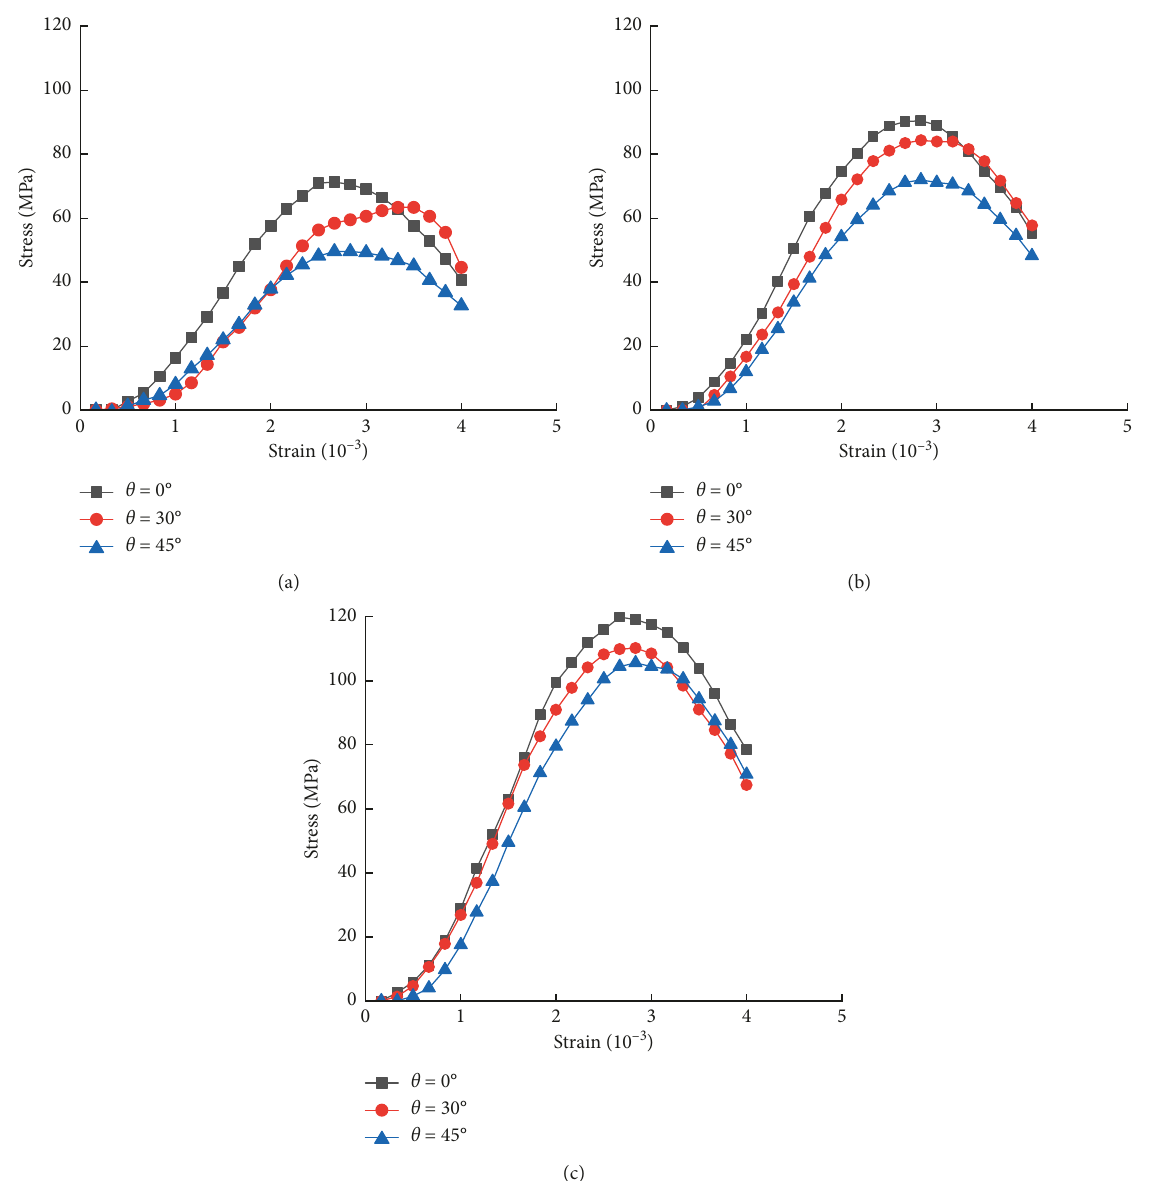
Figure 7: Stress-strain relation curves of different joints under three impact velocities: (a) V